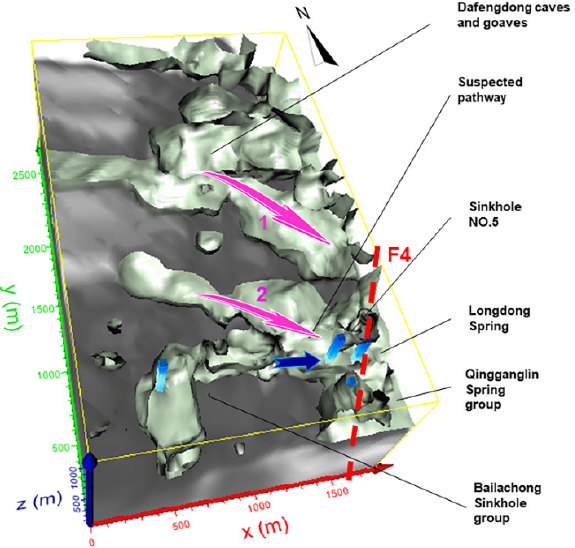
Figure 13. Suspected pathways obtained from transient electromagnetic survey.